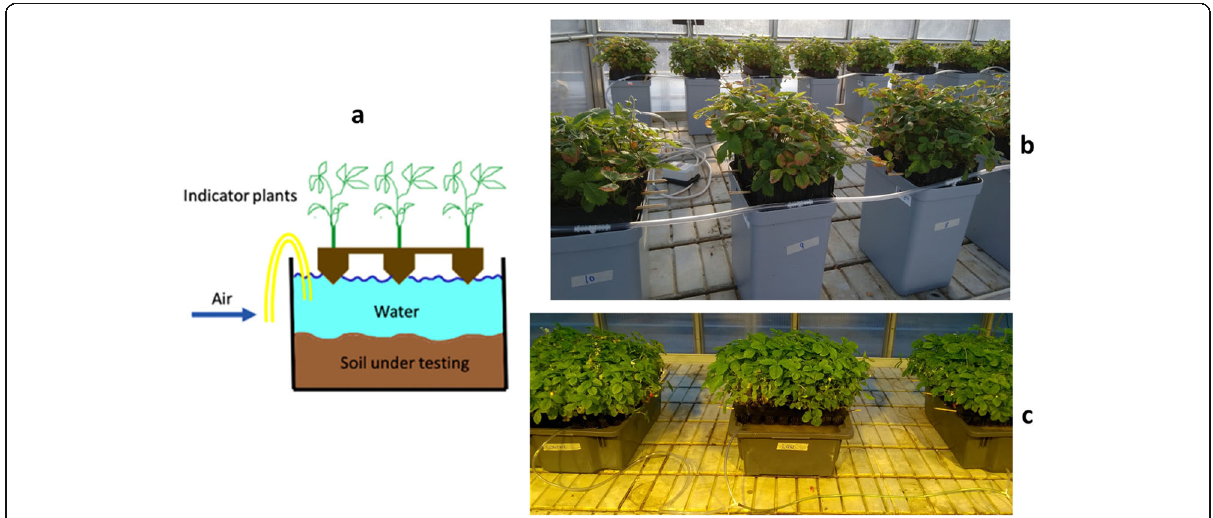
Fig. 4 Baiting unit used in this study for detection of P. fragariae . a Basic model of baiting unit. b, c Images of different baiting unit setups in a